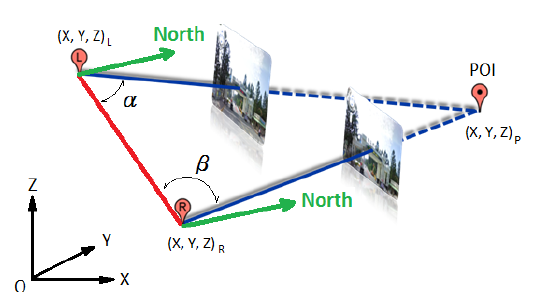
Figure 4. Positioning by intersection from two GSV